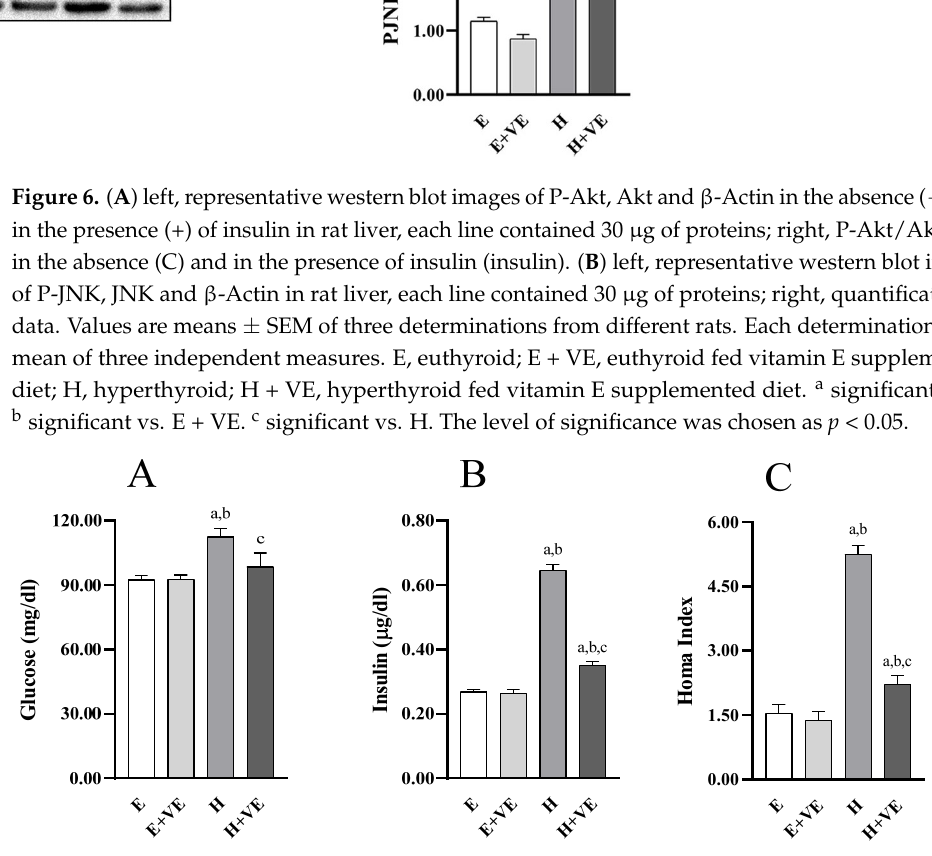
Figure 7. Parameters of glucose homeostasis: Blood glucose fasting levels ( A ), plasma insulin fasting levels ( B ), HOMA Index ( C ). Values are means ± SEM of eight determinations from different rats Each determination is the mean of three independent measures. E, euthyroid; E + VE, euthyroid fed vitamin E supplemented diet; H, hyperthyroid; H + VE, hyperthyroid fed vitamin E supplemented diet. a significant vs. E. b significant vs. E + VE. c significant vs. H. The level of significance was chosen as p < 0.05.